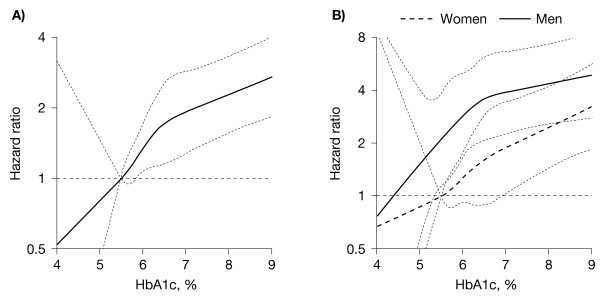
Spline curves for CVD in total population (A) and in men and women (B). Knots are quartiles of HbA1c in the total population. A) Dashed lines = 95%CI. B) Solid lines = 95%CI for men; dashed lines = women.